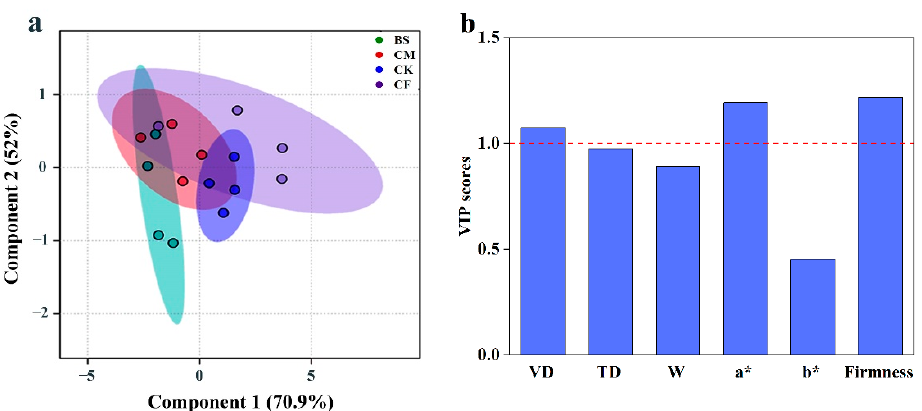
Figure 3. PLS-DA score plot ( a ) and VIP plot of the potential physicochemical markers ( b ) for the apples under different fertilizer treatments. VD: Vertical diameter, TD: Transverse diameter, W: Weight of single fruit, a*: red–green axis, b*: yellow–blue axis. CK: Control Group, CF: Chemical Fertilizer, CM: Composted Manure, BS: Biogas Slurry.